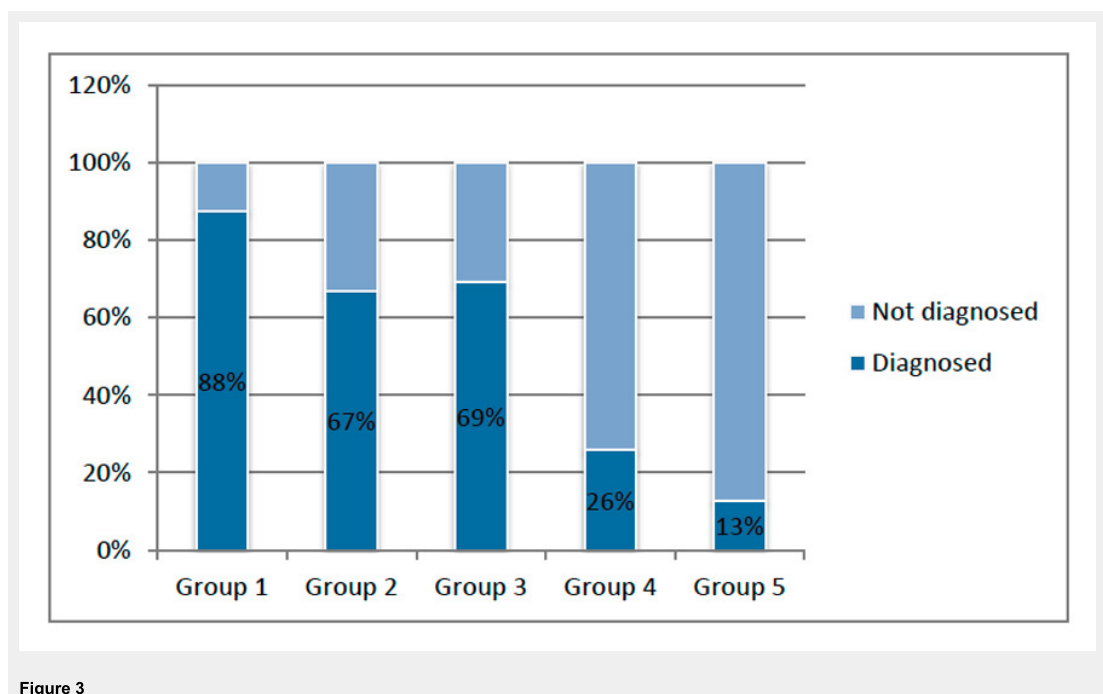
The percentage of prenatally diagnosed CHD cases in groups 1–5.